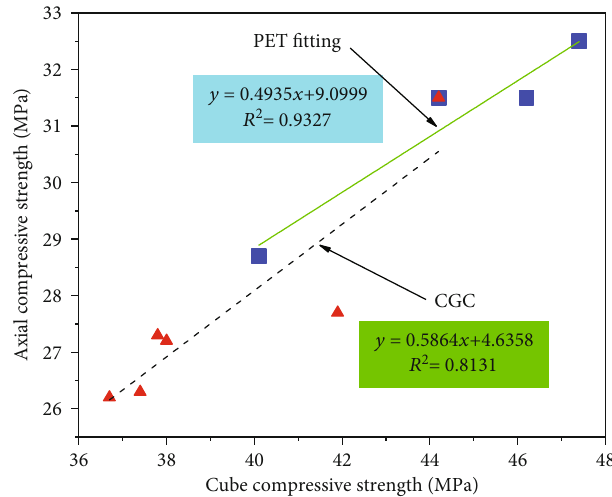
Figure 17: Relation between axial compressive strength and cube compressive